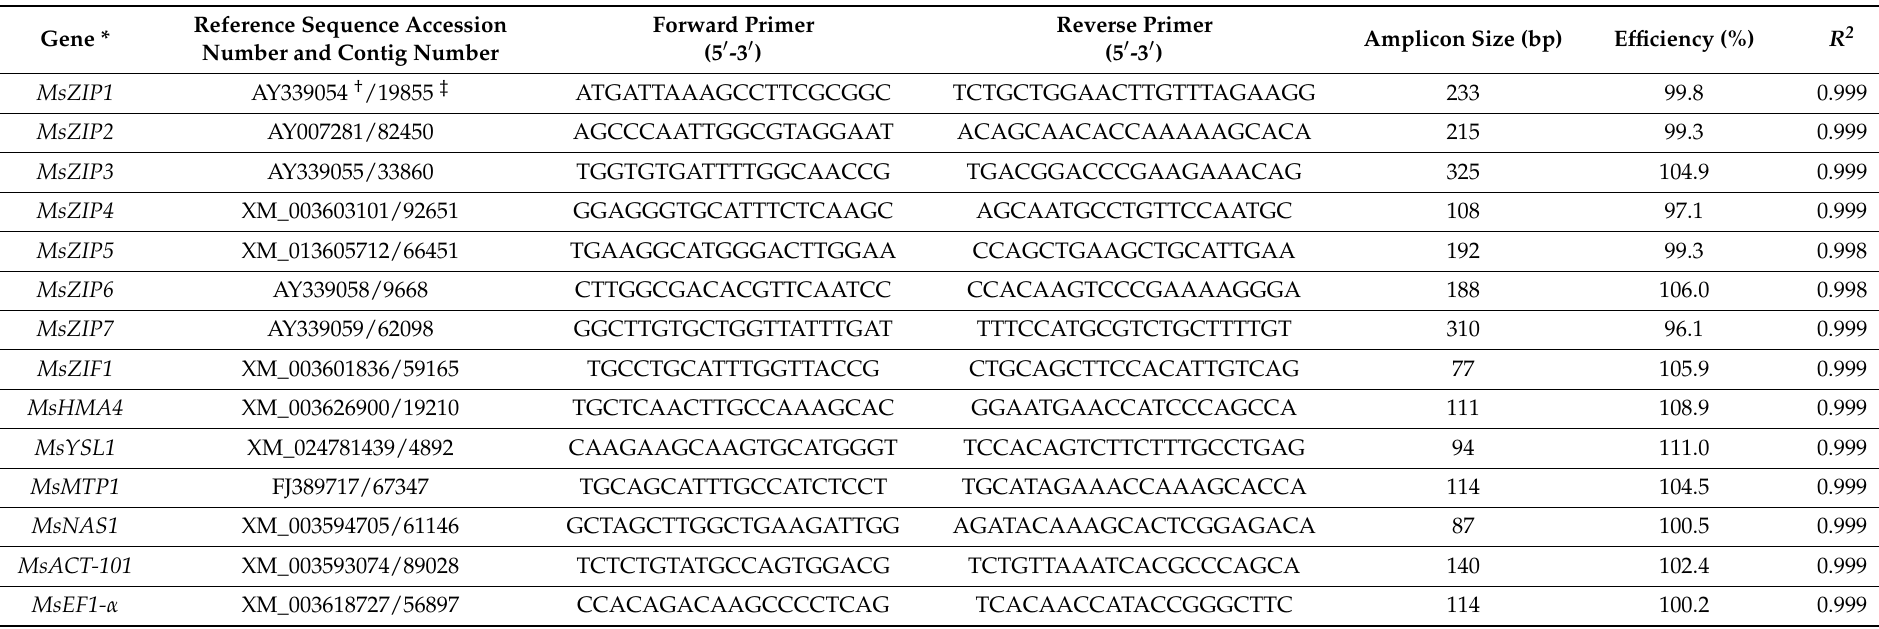
Table 2. Gene name and forward and reverse sequences of 14 newly designed primer pairs for the quantification of the expression of genes of alfalfa ( Medicago sativa ) encoding proteins involved in cellular zinc (Zn) influx and efflux and Zn chelation. Two reference genes (i.e., MsACT-101 and MsEF1- α ) were also designed. The length of the amplicons, the primer amplification efficiency (%), and R 2 of the standard curve are indicated. The reference sequences are indicated by the accession number of the Medicago truncatula sequences and by the contig number of the M. sativa sequences. The primers were designed online Primer-Basic Local Alignment Search Tool (BLAST). See Figure 1 for the full names of the genes.